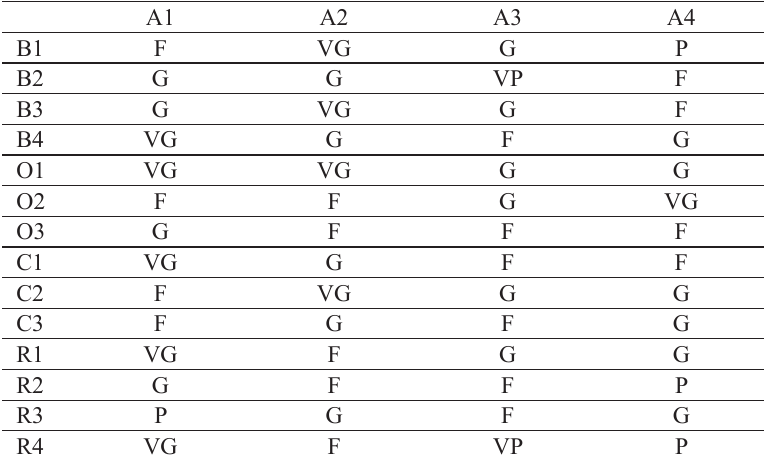
Fig. 5. Final ranking of the Table 10. A sample of fuzzy evaluation matrix evaluated by one of the experts